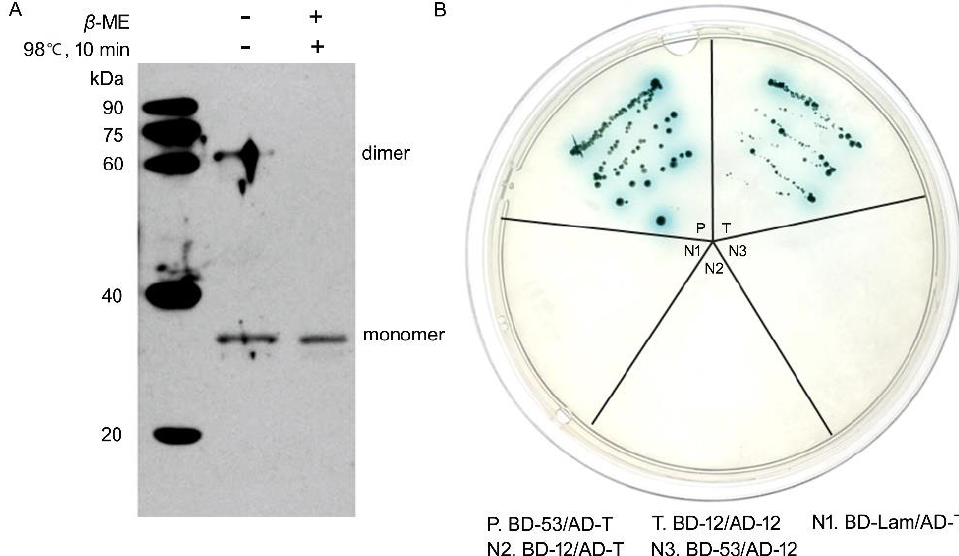
Figure 2. Heterologous expressed NbSWP12 can form homodimer. ( A ) Non-reduced SDS-PAGE combined with Western blotting analysis of His 6 -NbSWP12 recombinant protein expressed in Escherichia coli Rosetta. The NbSWP12 specific antibody can recognize monomer and dimer of NbSWP12. β -ME: β -mercaptoethanol. ( B ) A yeast two-hybrid assay was used to further determine the in vivo dimerization of NbSWP12. P, the fusion strain of pGBKT7-53 with pGADT7-T was used as the positive control. T, the fusion strain of pGBKT7- Nbswp12 with pGADT7- Nbswp12 was used as test group. The fusion strain of pGBKT7-lam with pGADT7-T (N1), the fusion strain of pGBKT7- Nbswp12 with pGADT7-T (N2), and the fusion strain of pGBKT7-53 with pGADT7- Nbswp12 (N3) were used as negative controls. The fusion strain in test group can grow on SD-Leu-Trp-His-Ade/ X- α -Gal medium and generate blue metabolites, indicating NbSWP12 can interact with each other and form homodimer.